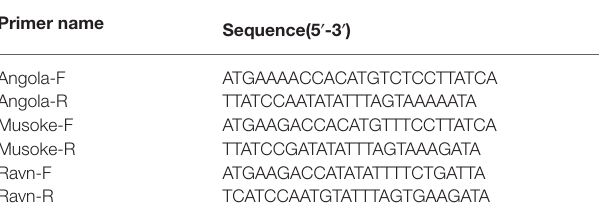
TABLE 1 | Primers for sequencing validation of the MARV GP